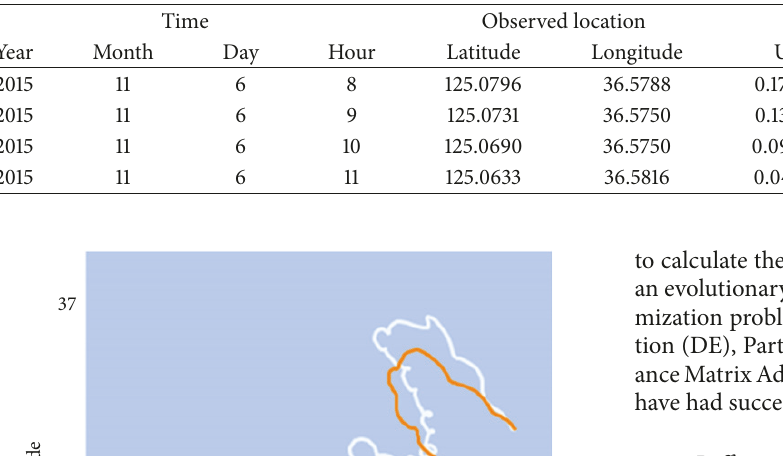
Table 2: Attributes of the training data (examples).